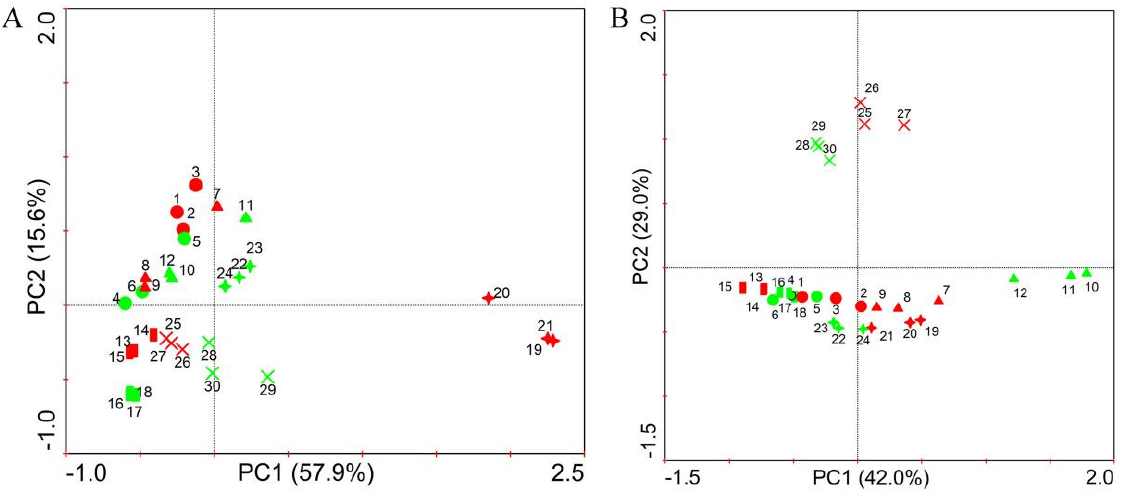
Figure 3. Principal component analysis of the soil bacterial ( A ) and fungal ( B ) communities collected from different treatments. 1–6 represent pepper, 7–12 represent tomato, 13–18 represent cotton, 19–24 represent eggplant, 25–30 represent maize. Red represents blank control (CK) treatment, green represents the treatment of strain